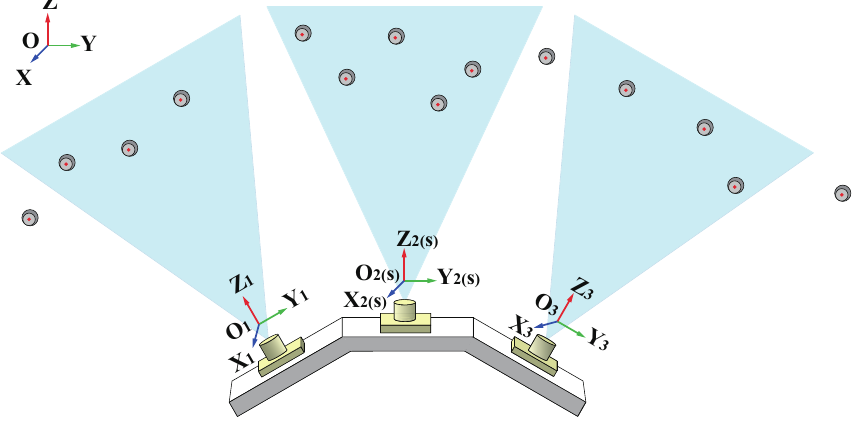
Figure 5. Measurement